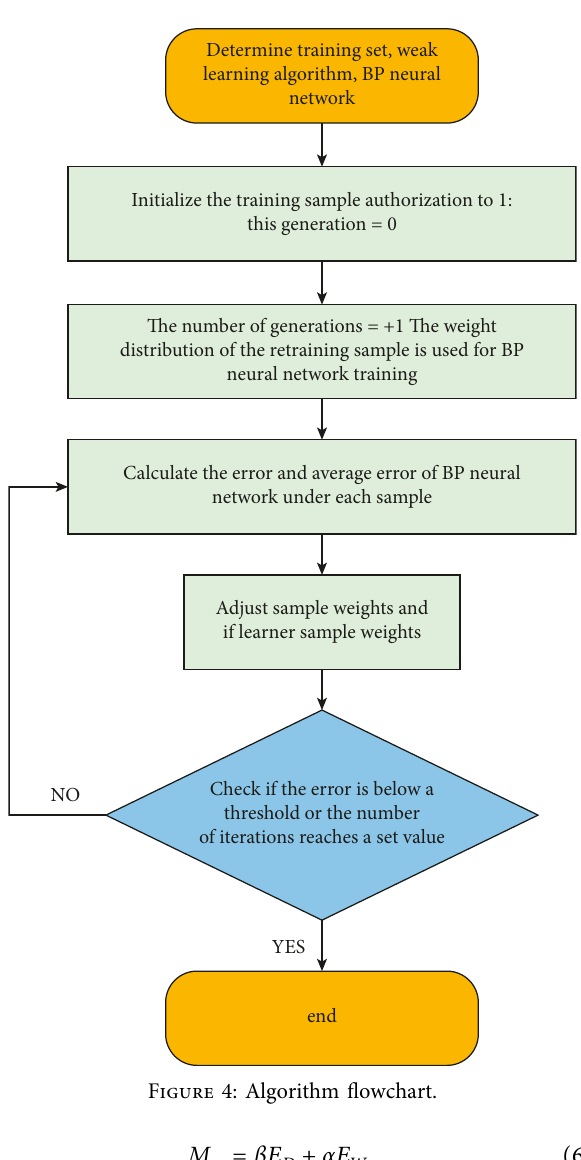
Figure 4: Algorithm